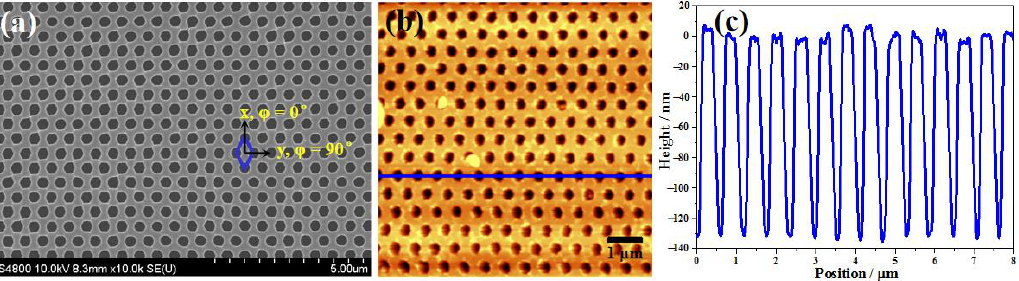
Figure 2. ( a ) SEM and ( b ) AFM images of the Au NHAs. ( c ) Cross-sections profile along the blue line in the AFM image.